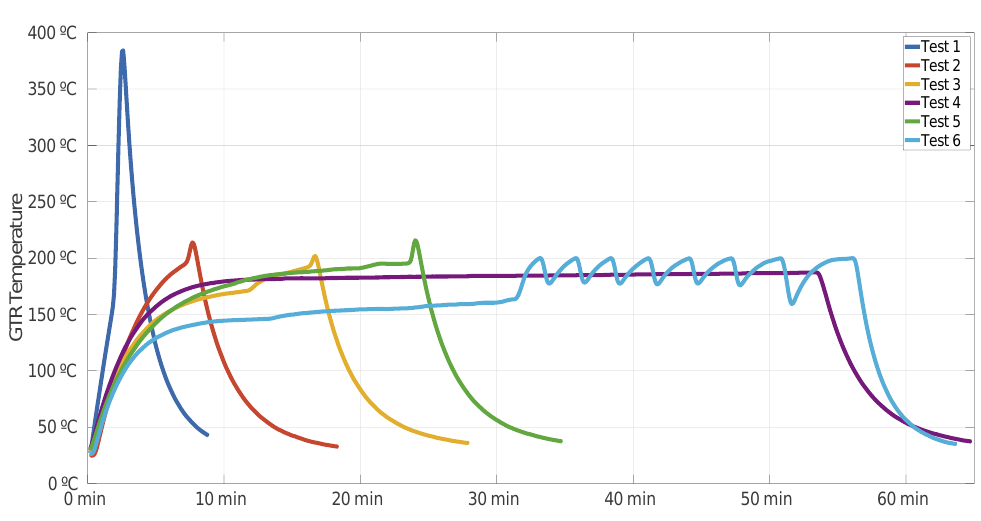
Figure 2. Monitored temperature of the tested samples versus time.